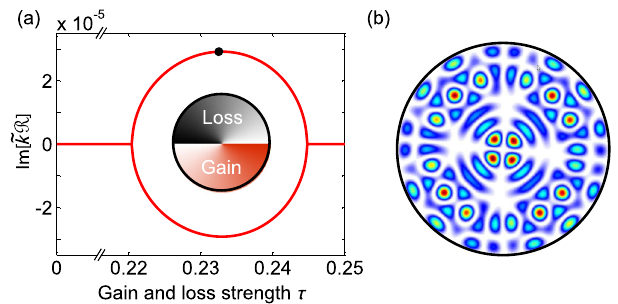
FIG. 4. A finite transition threshold always appears in an RT -symmetric disk, with or without additional symmetries.